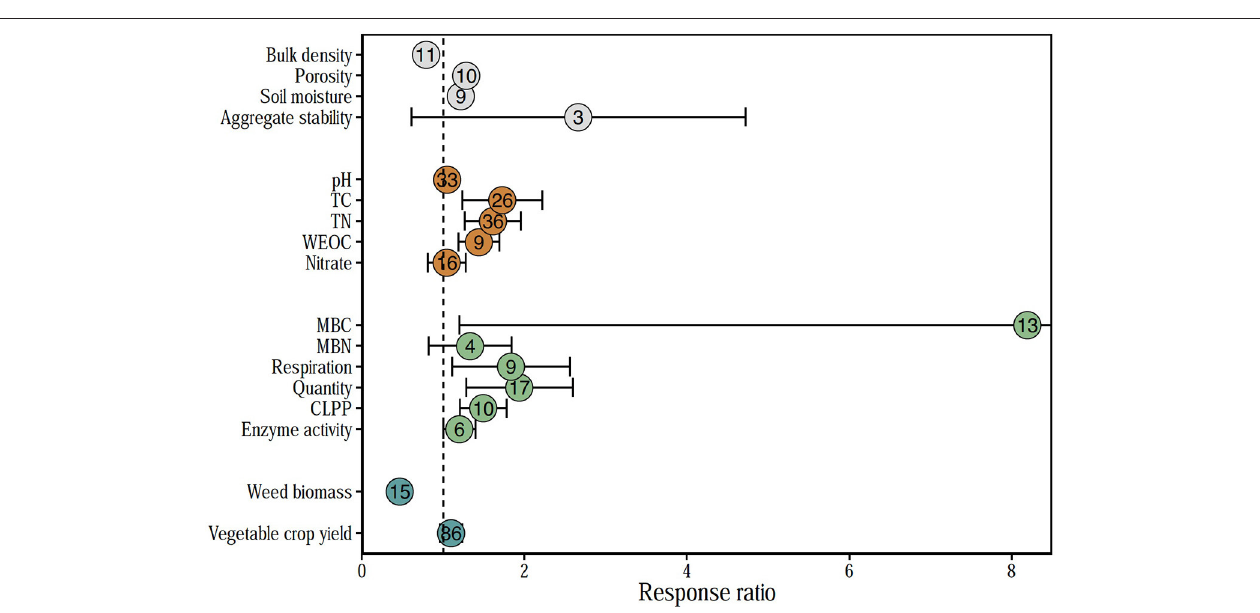
FIGURE 2 | Effects of alternative management practices on soil physical, chemical and biological properties as indicators of soil health. All points are presented as Response Ratios (RR) with the 95 % confidence interval and the respective number of comparisons (n) presented inside the circle. TC, total carbon; TN, total nitrogen; WEOC, water extractable organic carbon; MBC, microbial biomass carbon; MBN, microbial biomass nitrogen; CLPP, community level physiological profile.